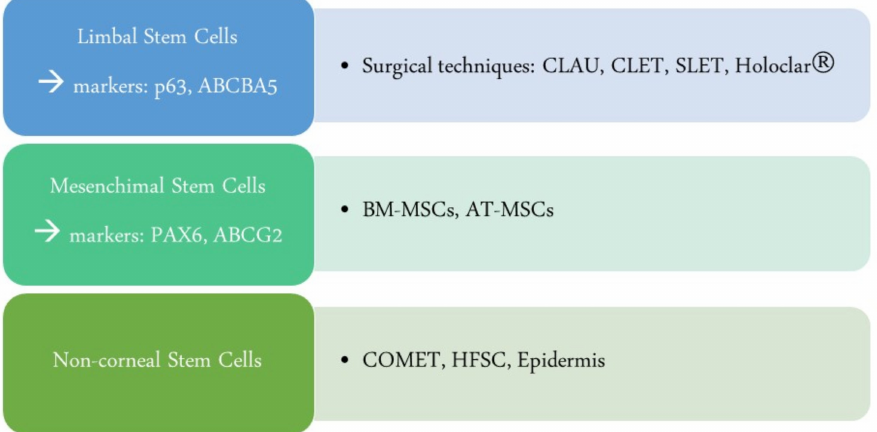
Figure 3. Corneal stem cell transplantation: This scheme summarizes the current main surgical techniques to replace limbal stem cells. CLAU: Conjunctival–limbal autograft; CLET: ex vivo culti- vated limbal epithelial transplantation; SLET: simple limbal epithelial transplantation; Holoclar ® , ex vivo expanded autologous human corneal epithelial cells containing stem cells; BM-MSCs: bone marrow-derived mesenchymal stem cells; AT-MSCs: adipose-tissue-derived mesenchymal stem cells; COMET: autologous ex vivo cultivated oral mucosal epithelial cells; HFSCs: hair follicle stem